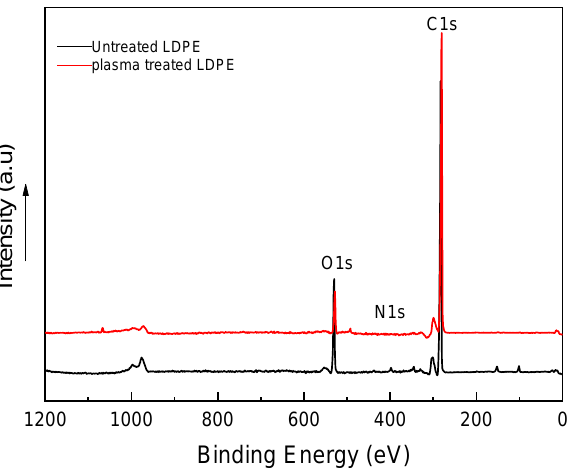
Figure 5. X-ray photoelectron spectroscopy (XPS) spectra for treated and untreated LDPE samples. Table 1. XPS atomic composition summary for LDPE samples. Atomic Conc. (at %) Element Samples C 1s